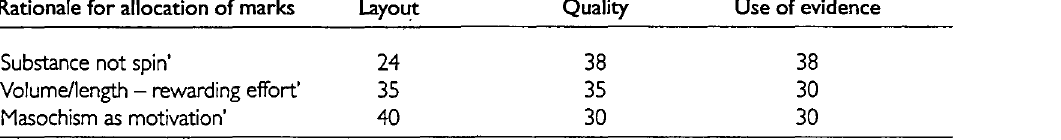
Table I: Students' percentage mark weightings for the three categories of